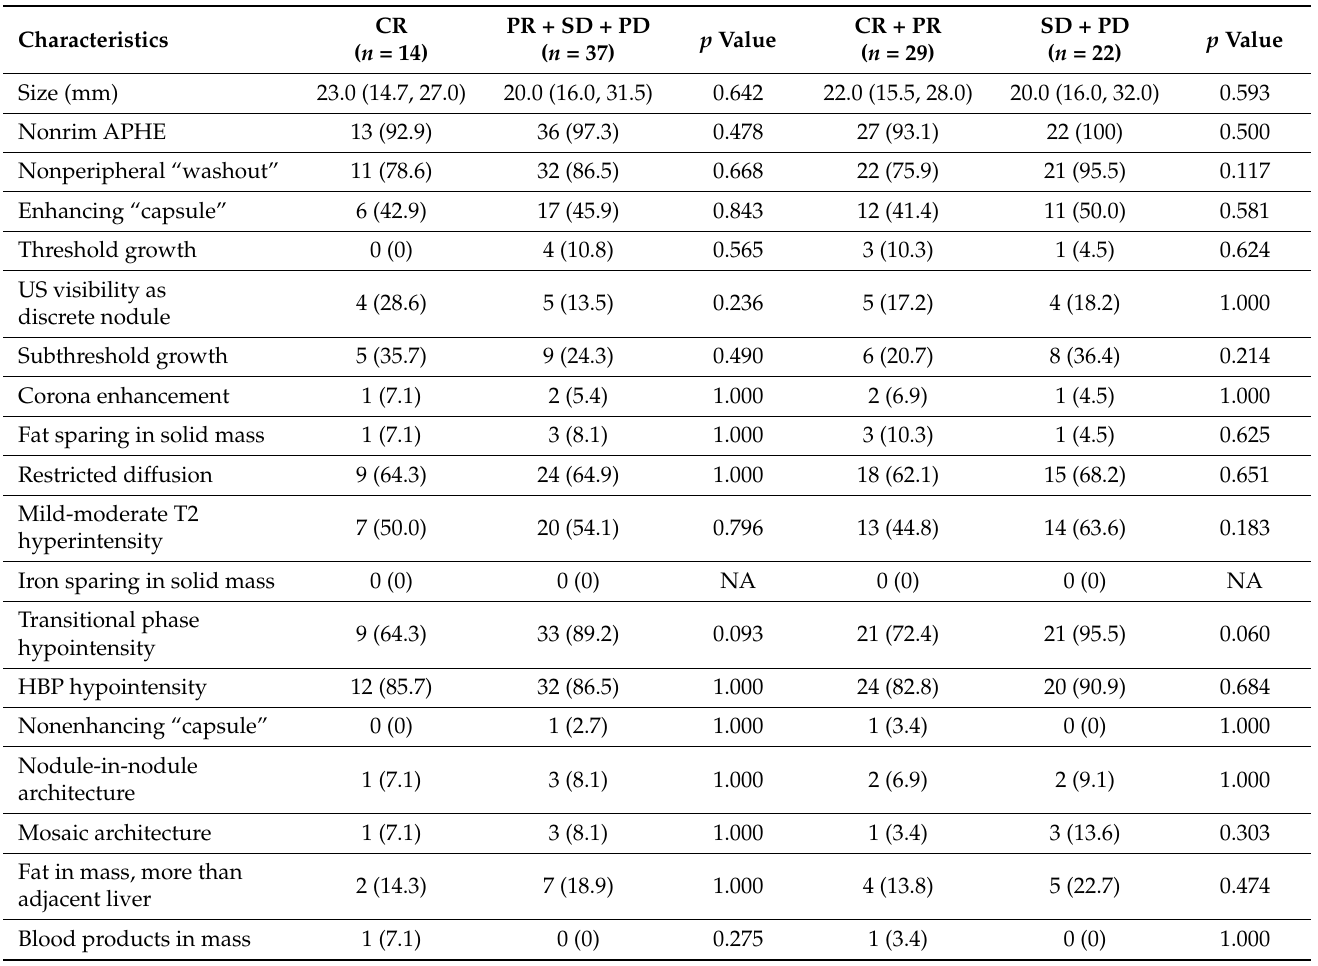
Table 2. Differences in LI-RADS major and ancillary features favoring malignancy according to treatment